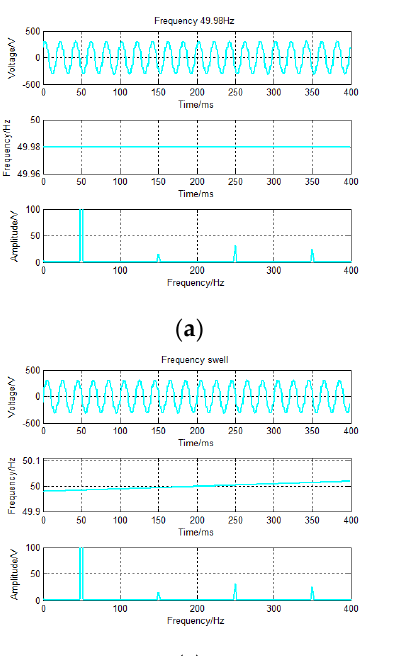
Figure 12. Experiment data for voltage frequency heavy fluctuations. ( a ) Frequency 49.5 Hz; ( b ) Frequency 50.5 Hz; ( c ) Frequency swell; ( d ) Frequency sag.